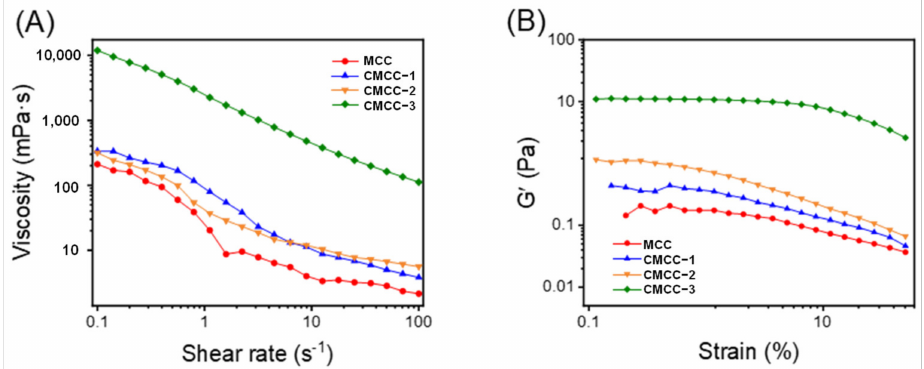
Figure 3. The ( A ) shear viscosity and ( B ) storage modulus (G (cid:48) ) of MCC and CMCC in a strain sweep